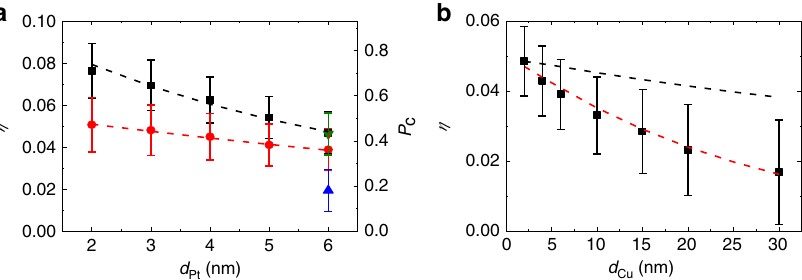
Fig. 6 Quantum ef fi ciency ( η ). a The η of the sap/Pt( d Pt )/Co(3)/MgO(3) (black squares) and sap/Co(3)/Pt( d Pt ) (red circles) samples with a photon energy of 1.58 eV. The blue up-triangle and olive down-triangle is data with a photon energy of 1.38 and 1.73 eV, respectively, of the sap/Pt(6)/Co(3)/MgO (3) sample. The dashed lines are the spin diffusion calculation with a spin diffusion length of Pt of 6 nm (black line) and 9 nm (red line) (see Methods). The right column of a shows the spin-collection probability on Co ( P c ), calculated with a spin diffusion length of Pt of 6 nm. b The η of the sap/Pt(5)/Cu( d Cu )/ Co(3)/MgO(3) samples (black squares) with a photon energy of 1.58 eV. The dashed lines are the spin-diffusion calculation with a spin diffusion length of Cu of 400 nm (black line) and 25 nm (red line) (see Method). The error bar indicates the con fi dence interval of η considering the uncertainty of the dynamics Kerr rotation, static Kerr rotation, and light absorption.